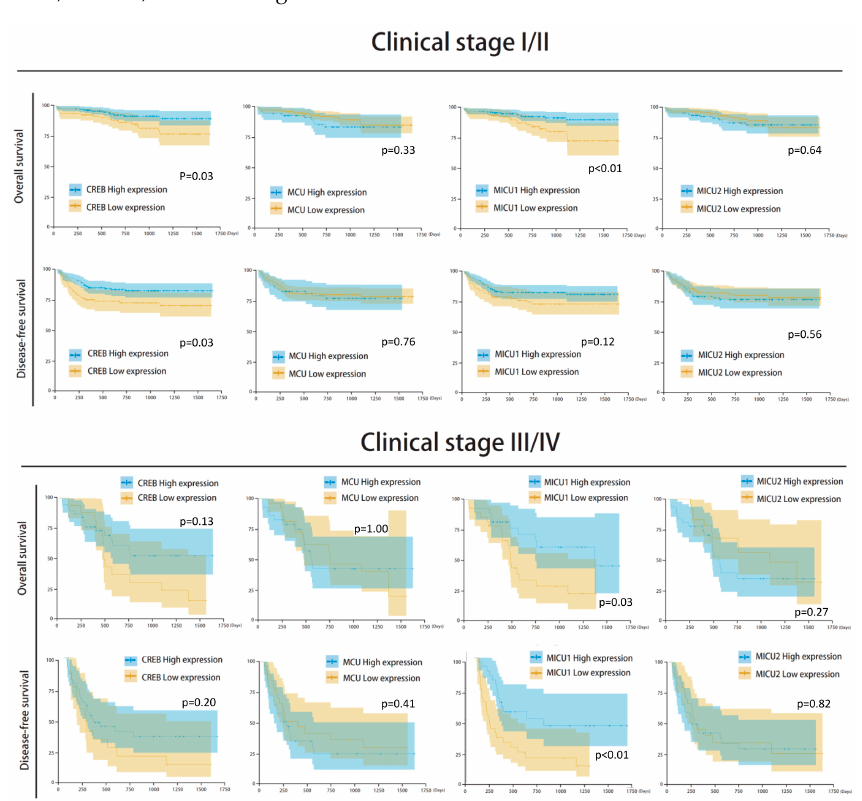
Figure 5. Kaplan–Meier analysis of the four mitochondria gene expression in clinical stage I/II and III/IV.